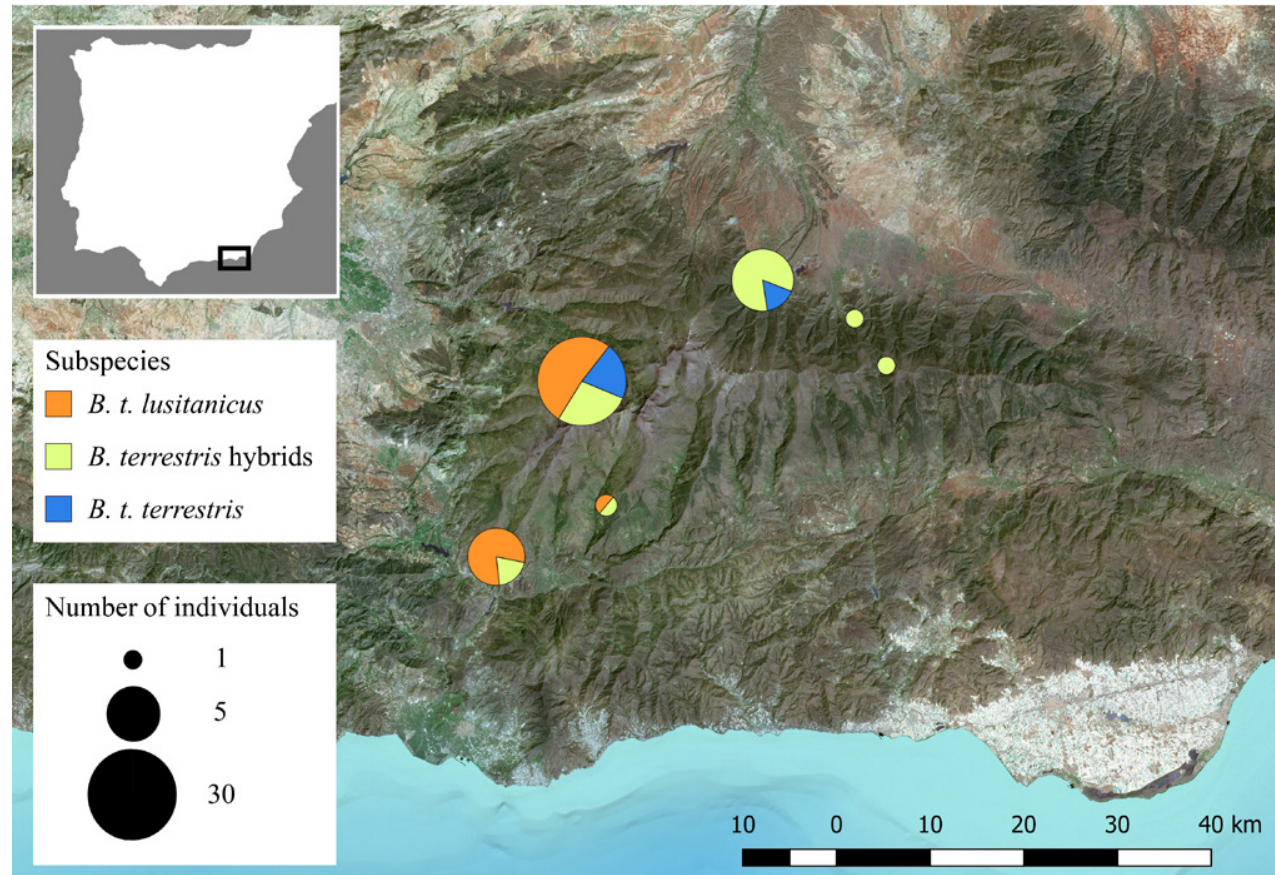
Fig 1. Frequency of Bombus terrestris lusitanicus , Bombus terrestris terrestris and hybrids (those with morphological subspecies identification and 16S haplotype that did not match i. e. B. t. lusitanicus with A-haplotype and B. t. terrestris with G-haplotype) in the National Park of Sierra Nevada (southern Spain). Size of the circles is proportional to the total number of individuals sampled at each location. The high density of greenhouses can be seen in the lower right corner of the figure. Ortophotograph obtained from